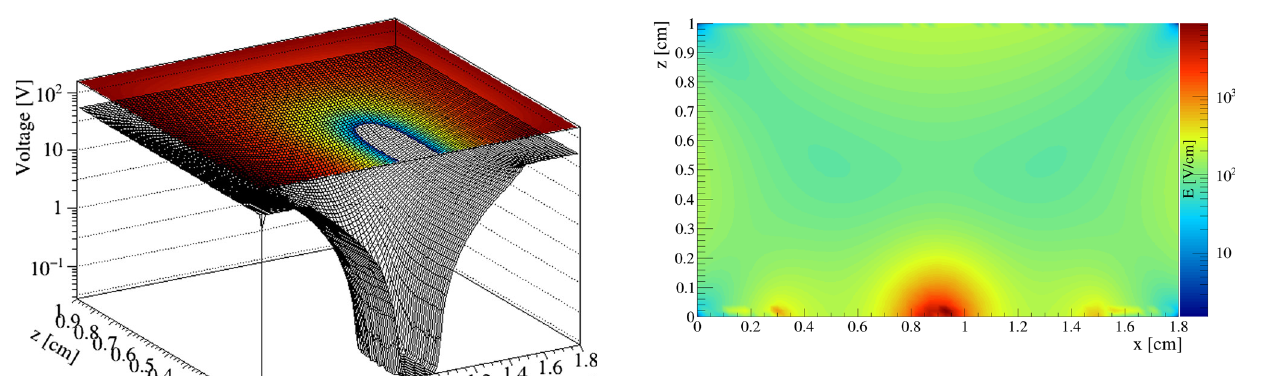
Fig. 12 The electric field distribution in the detector when a positive voltage of 400 V was applied to the outside surface contact